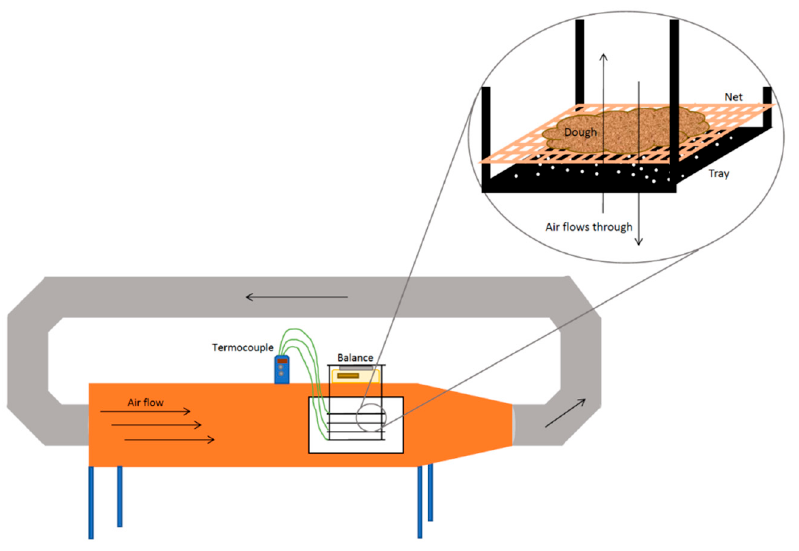
Figure 1. Convective tray-dryer setup.